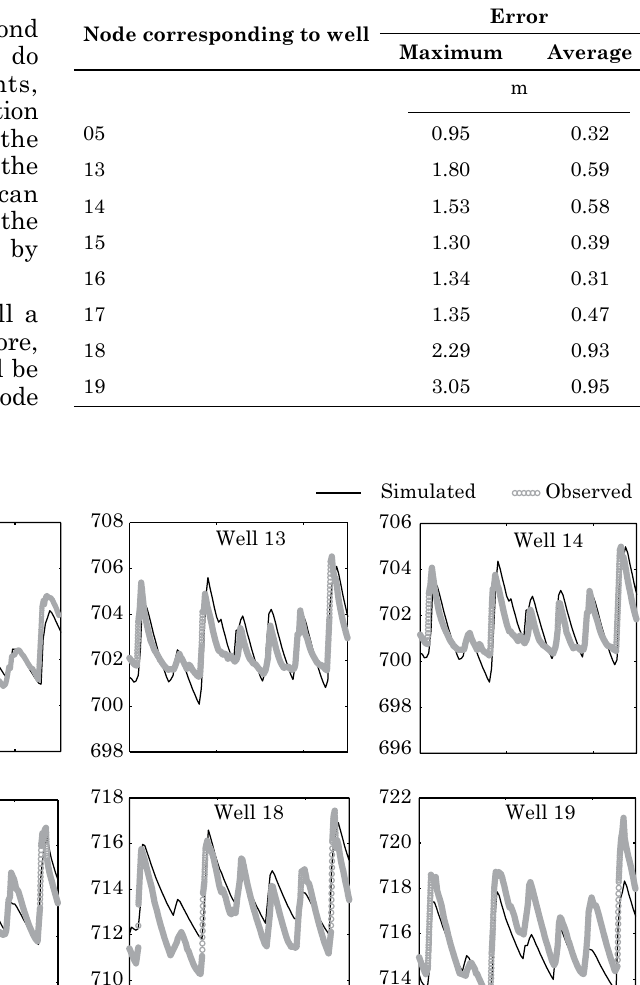
Table 1. Maximum and mean errors at the nodes used in the calibration of the numerical model for the ribeirão da onça watershed Error node corresponding to well